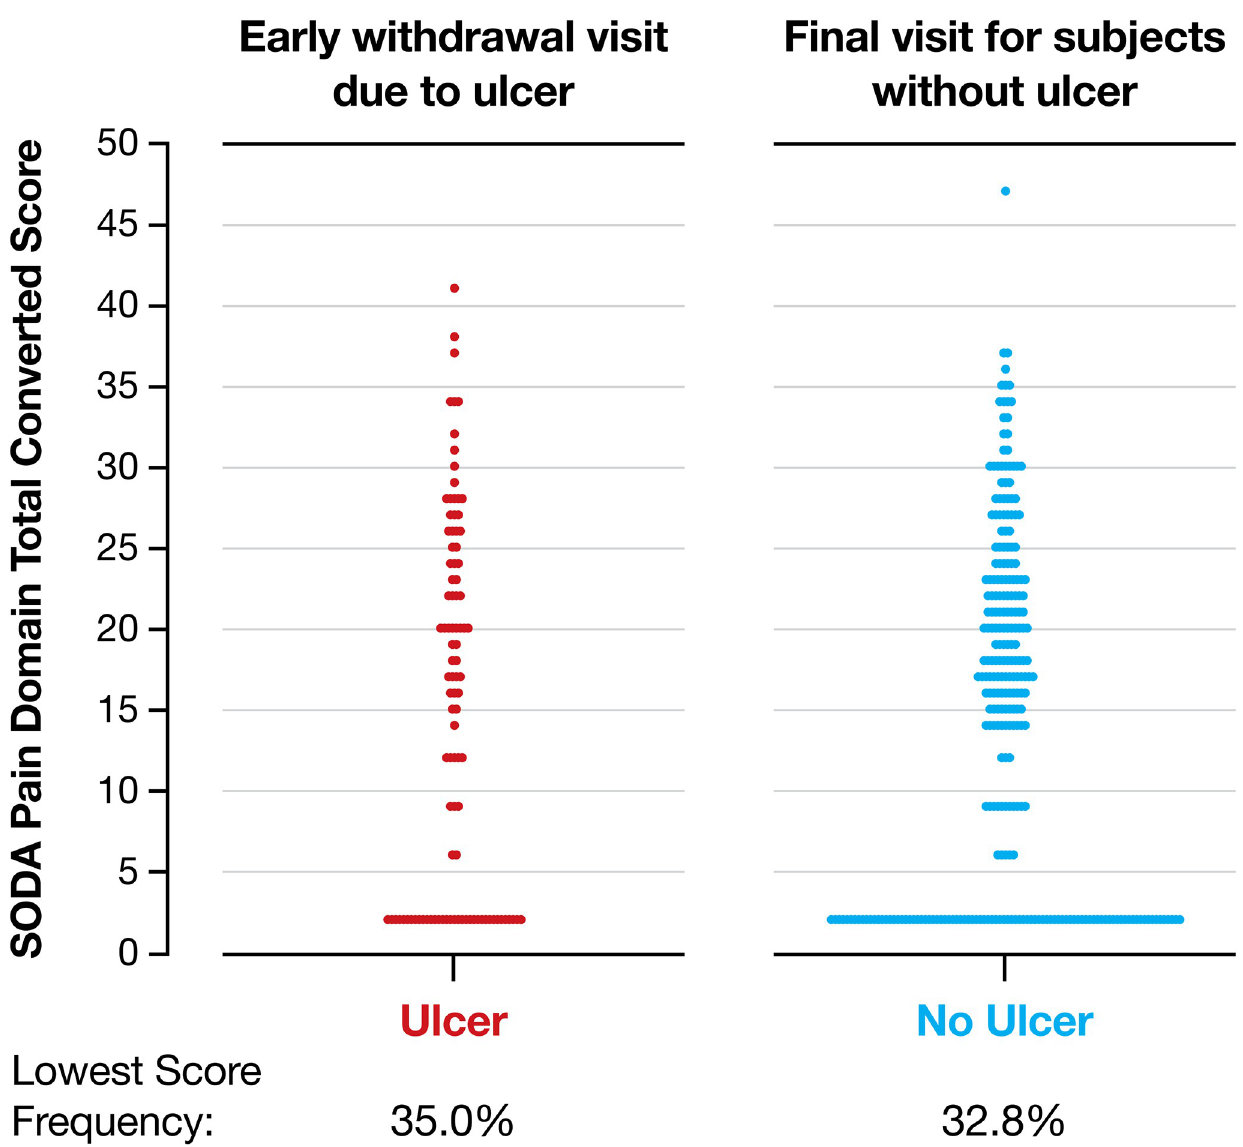
Fig 2. SODA pain intensity scores of patients who had an ulcer either at the final visit of the study (6 months) or at premature study exit for any other reason or completed the study without ulcer. Data are number of patients. SODA, Severity of Dyspepsia Assessment.